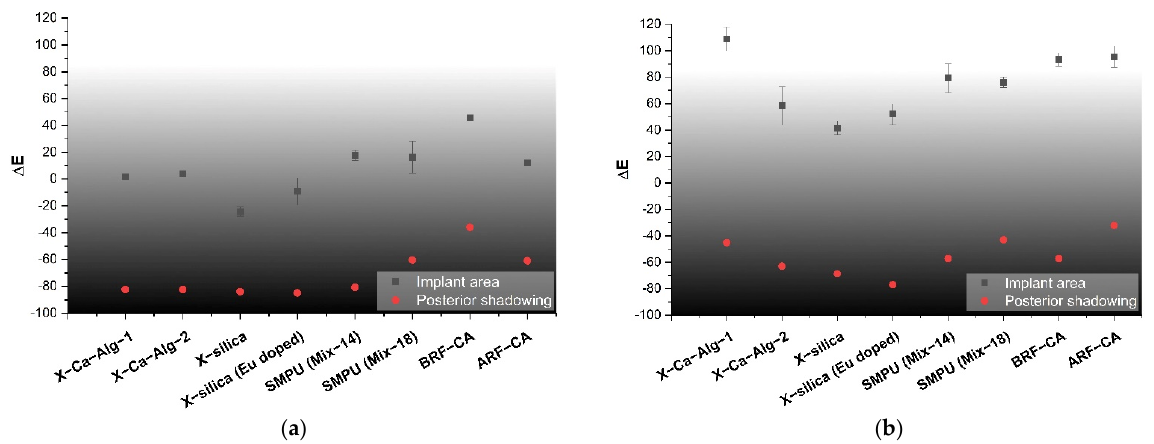
Figure 10. Echogenicity of the aerogels at 8.5 MHz tabulated according to the classifications indicated in Table 3: ( a ) SC and ( b ) SM compared to control, calculated using Equations (4a) and (4b), Table 2.